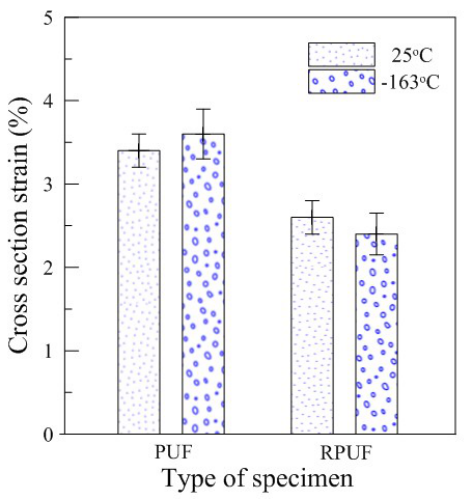
Figure 6. Cross-sectional strain of the rigid PUF after the conventional compressive test. Table 4. Average cross-section of the rigid PUF specimen after the conventional test. Material